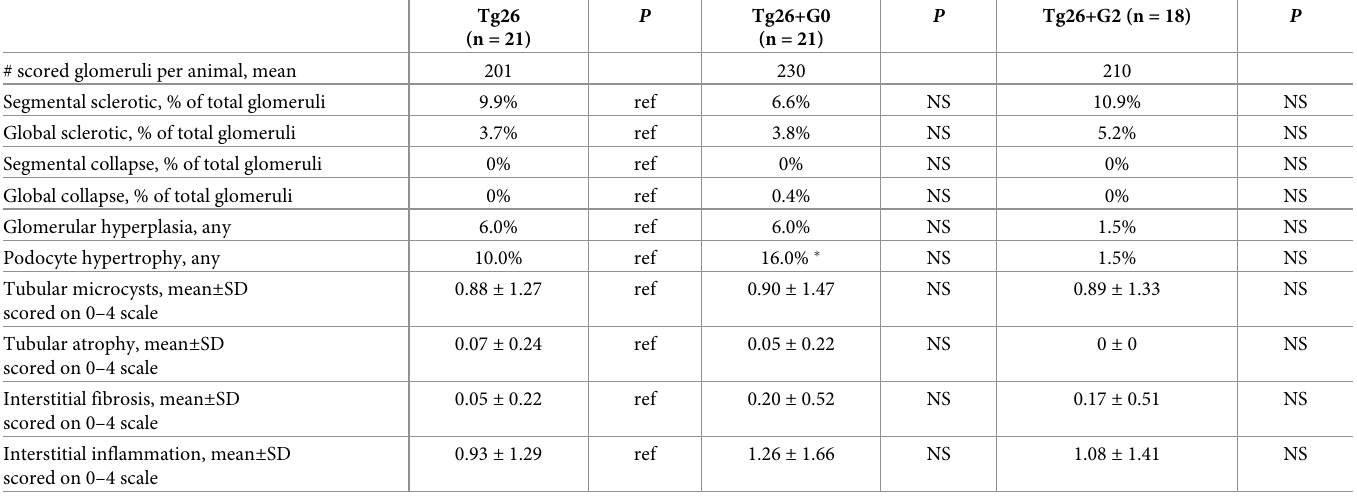
Table 1. Histopathology of Tg26 and Tg26 x APOL1 dual transgenic